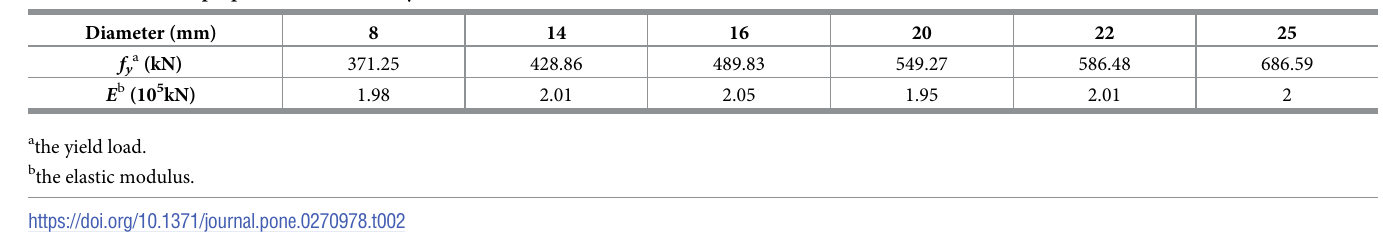
Table 2. Mechanical properties of the ordinary